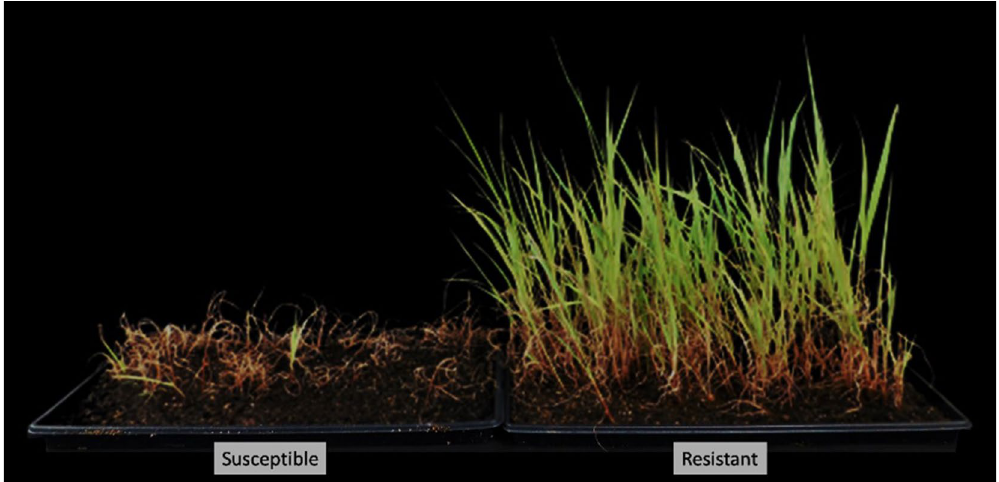
Figure 3. The response of susceptible (AS) and resistant (AR) plants at the discriminant rate of the ALS- inhibitor nicosulfuron (Accent Q, 63 g